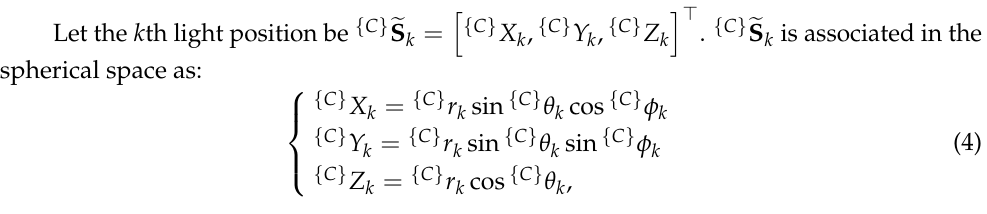
Figure 2. Coordinate setups for modeling imaging geometry and light